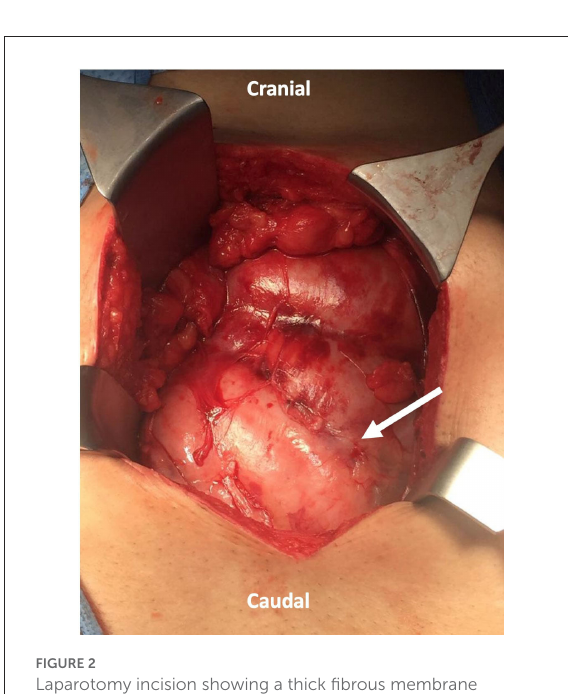
FIGURE4 Laparotomy incision with wound protector showing a thick fibrous membrane encasing the small bowel resembling a cocoon (Arrow indicates the